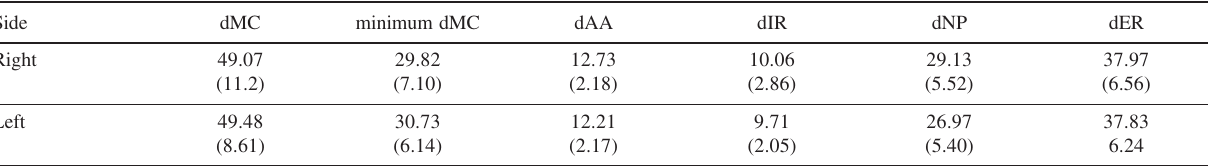
dMC = distance between the apex of coracoid process and the point of entry of the musculocutaneous nerve into the coracobrachial muscle minimum dMC = smallest distance between the apex of coracoid process and the musculocutaneous nerve dAA = smallest distance between the apex of coracoid process and the acromial artery dIR =distance between the lesser tubercle of the humerus and the apex of coracoid process as measured at maximum internal rotation of the humerus dNP = distance between the lesser tubercle of the humerus and the apex of coracoid process as measured at neutral position of the humerus dER = distance between the lesser tubercle of the humerus and the apex of coracoid process as measured at maximum external rotation of the humerus